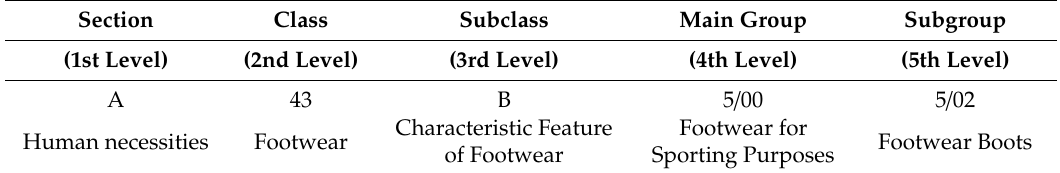
Table 1. International Patent Classification (IPC) code structure.